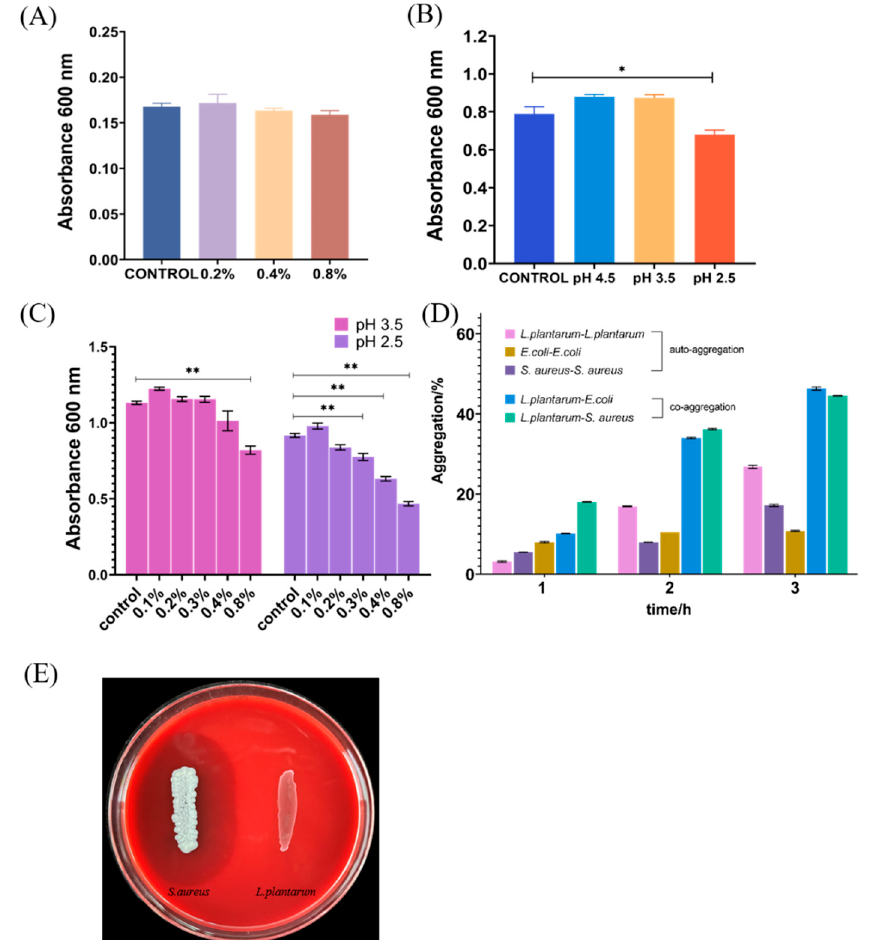
Figure 1. Absorbance of L. plantarum after incubation for 16 h in MRS broth at 0.2%, 0.4%, 0.8% bile salts ( A ) and pH 2.5, 3.5, 4.5 ( B ). ( C ) The absorbance of L . plantarum after incubation in different bile salts concentrations of the isolate after pre-exposure to low pH. ( D ) Auto-aggregation and co-aggregation with S . aureus and E . coli as determined after various times of incubation durations at 37 °C. ( E ) Hemolytic activity. Each experiment was independently repeated three times. * p < 0.05, ** p < 0.01.